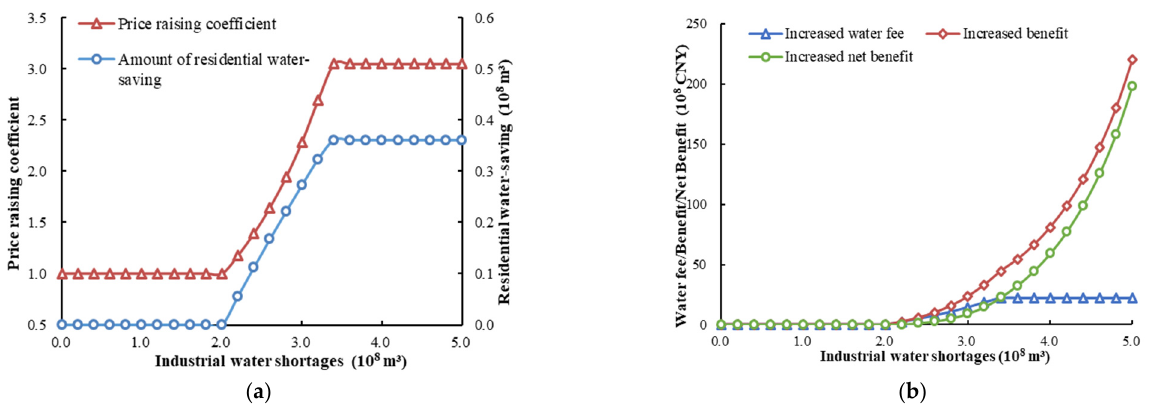
Figure 6. ( a ) The curves of the optimal price raising coefficient and residential water-saving with the change of industrial water shortages ( b ) The curves of increased water fee, increased benefit and increased net benefit with the change of industrial water shortages.